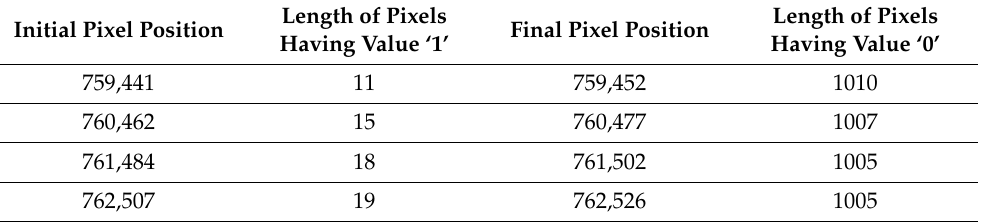
Figure 11. Complete RLE array for reference image ID (red box shows the values utilized for explanation in Table 4.) Table 4. Pixel positions and length of pixels having values ‘0’ and ‘1’for mask generation for reference image ID.